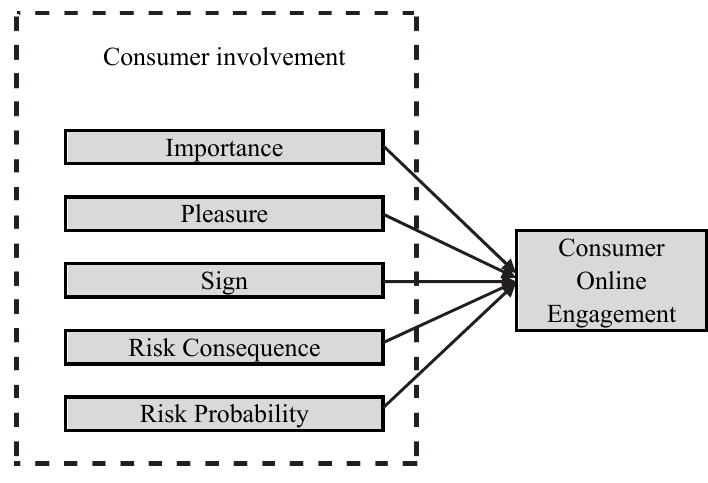
Fig. 1. Proposed conceptual